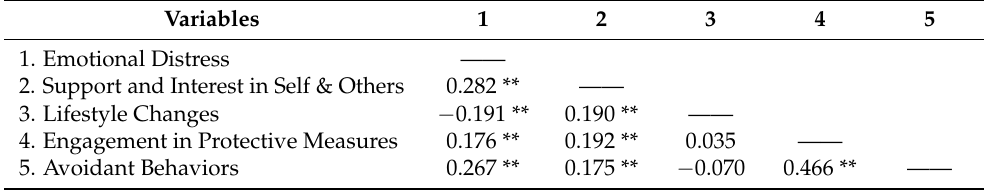
Table 1. Correlation among CMHQ subscales.